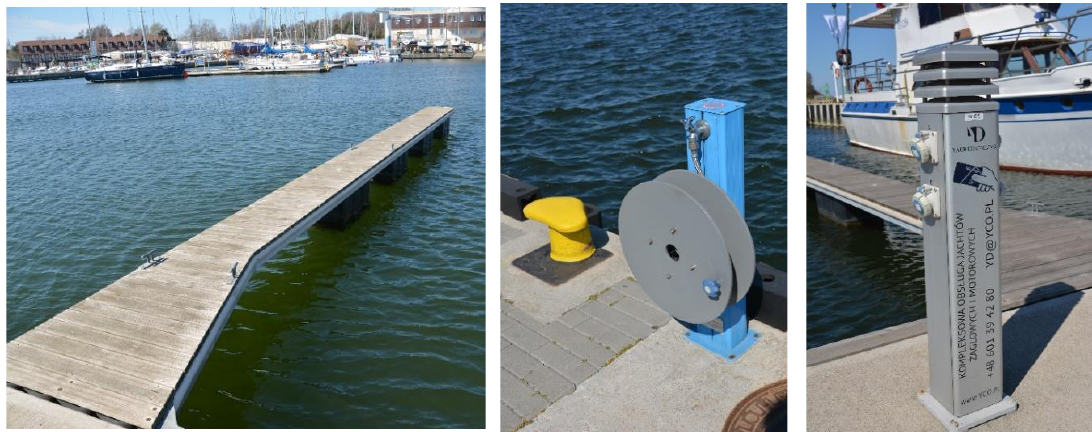
Figure 6. A platform and components of infrastructure: a hydrant and an electrical container.